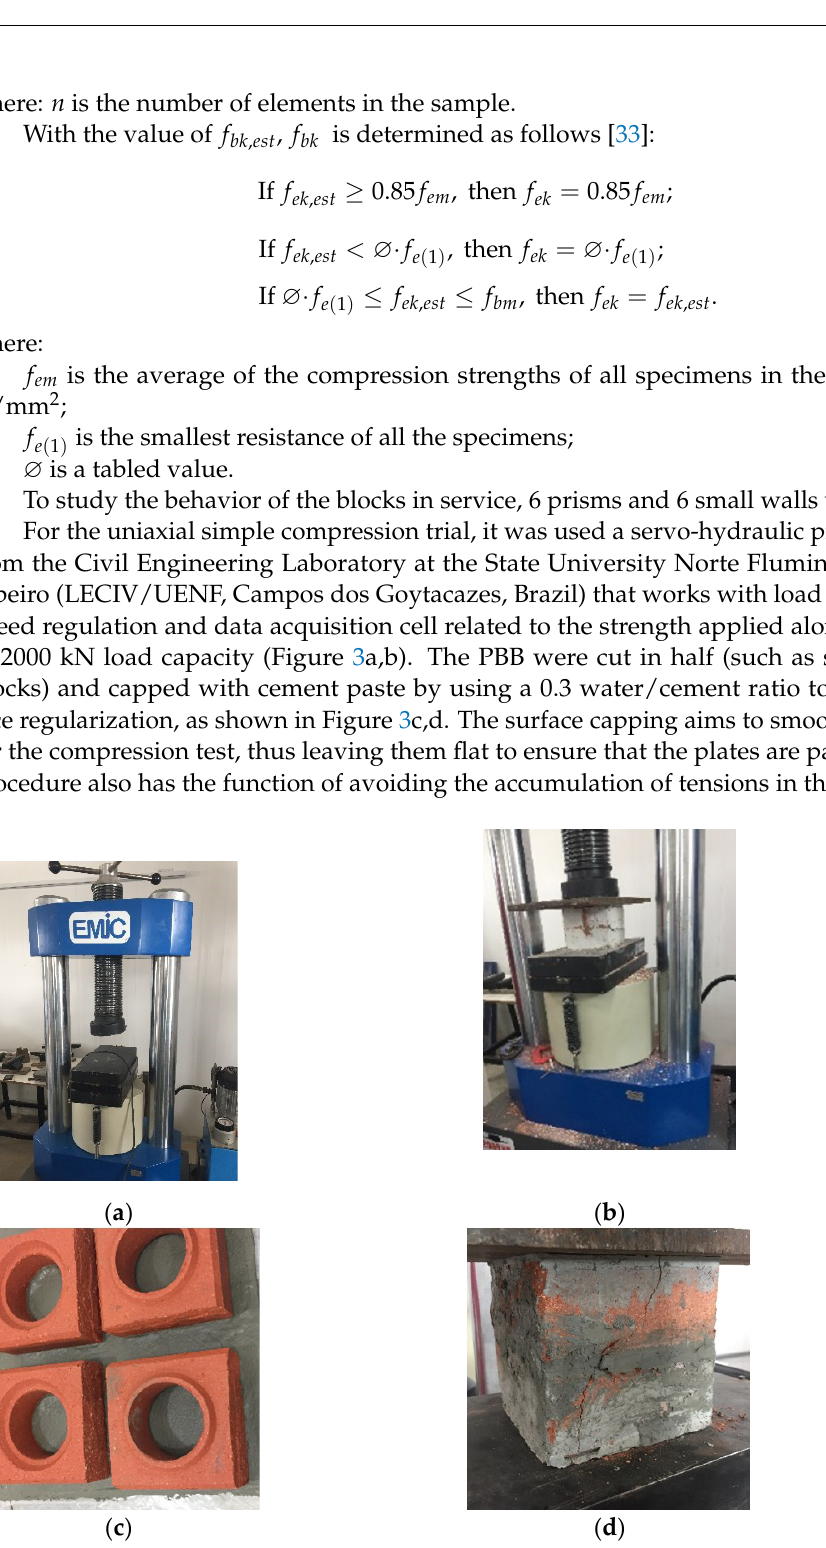
Figure 3. Experimental compressive tests: ( a ) 2000 kN EMIC Press; ( b ) PBB in the press; ( c ) capped PBB; ( d ) PBB capped in the press.